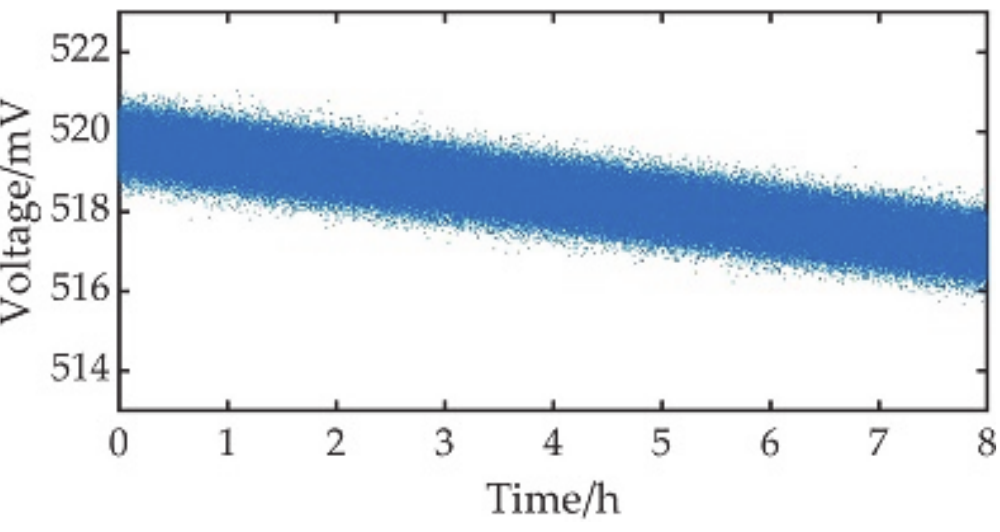
Figure 7. Simulation results of PD output voltage in Experiment 2.